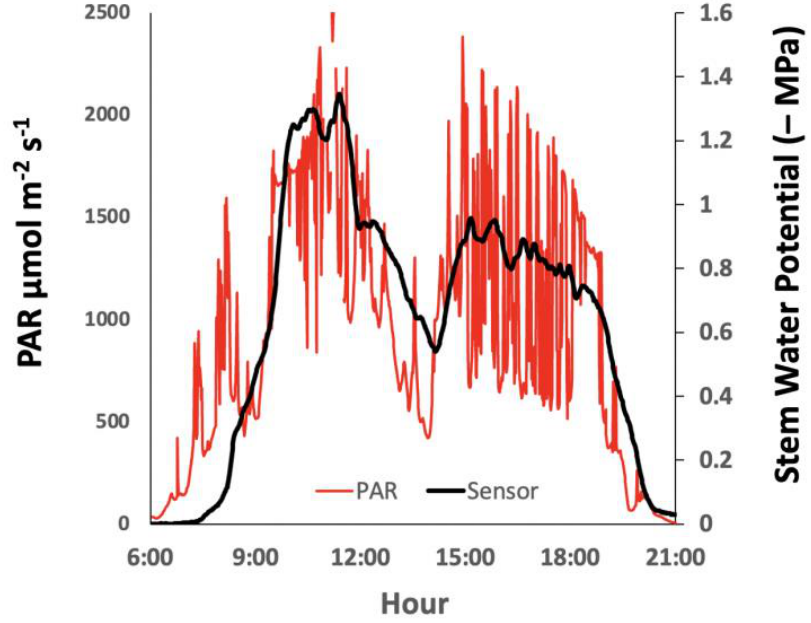
Figure 5. Example of the microtensiometer response in an apple tree to rapid changes in radiation on a variably cloudy day. Data were collected every minute to examine response time. Stem potentials are inverted to make the comparison to radiation more direct.